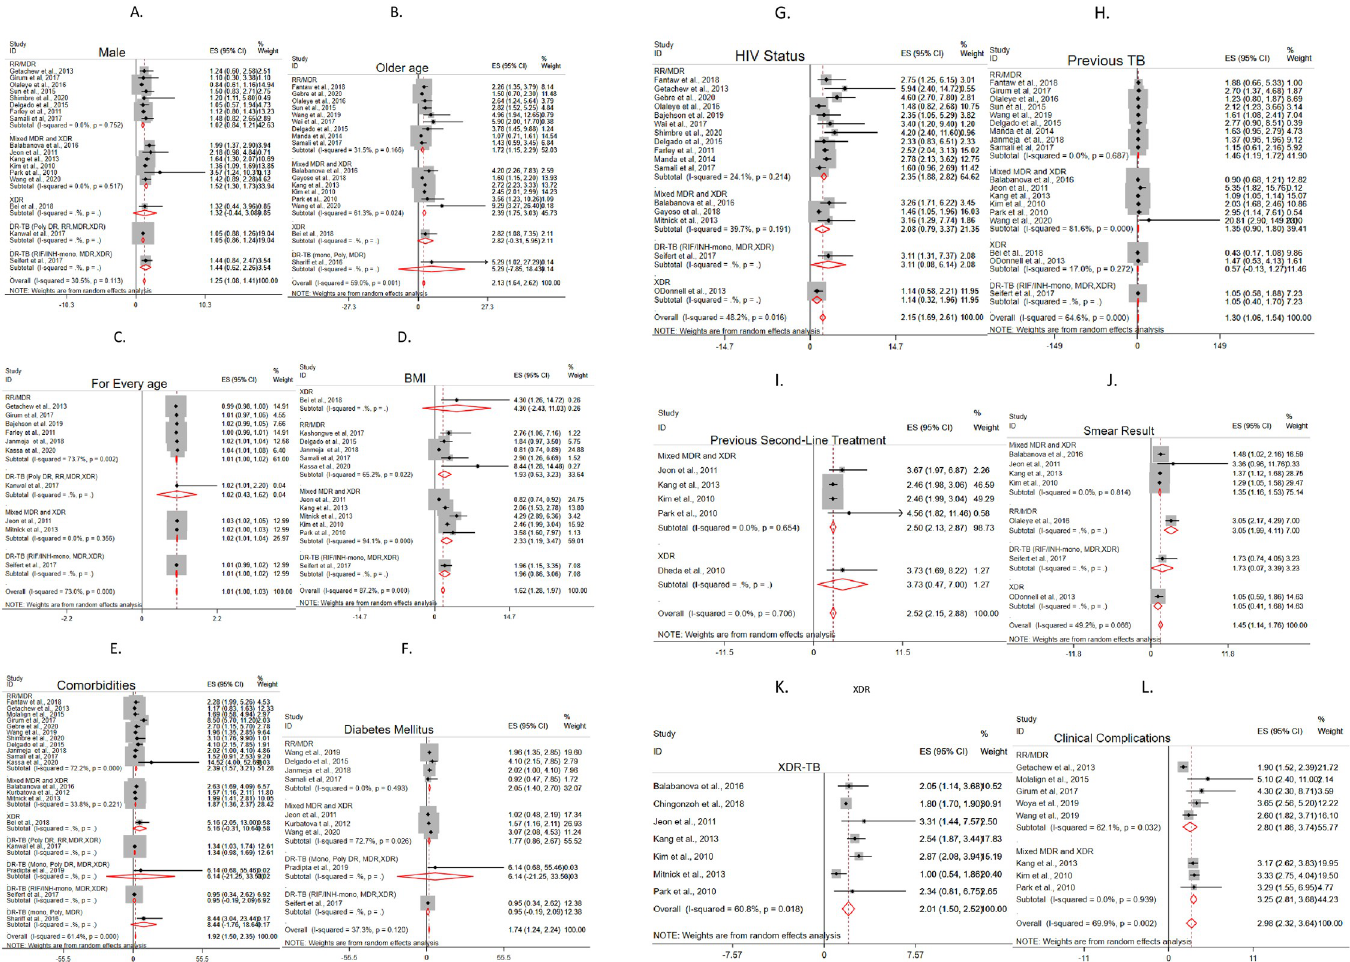
Fig 10. Forest plot for predictors of mortality in patients with drug-resistant tuberculosis. A. Male sex B. Older age C. For every age D. Undernutrition E. Presence of any co-morbidity F. Diabetes G. HIV co-infection H. TB history I. Previous second-line treatment J. Smear positive K. XDR-TB L. Presence of clinical complication.